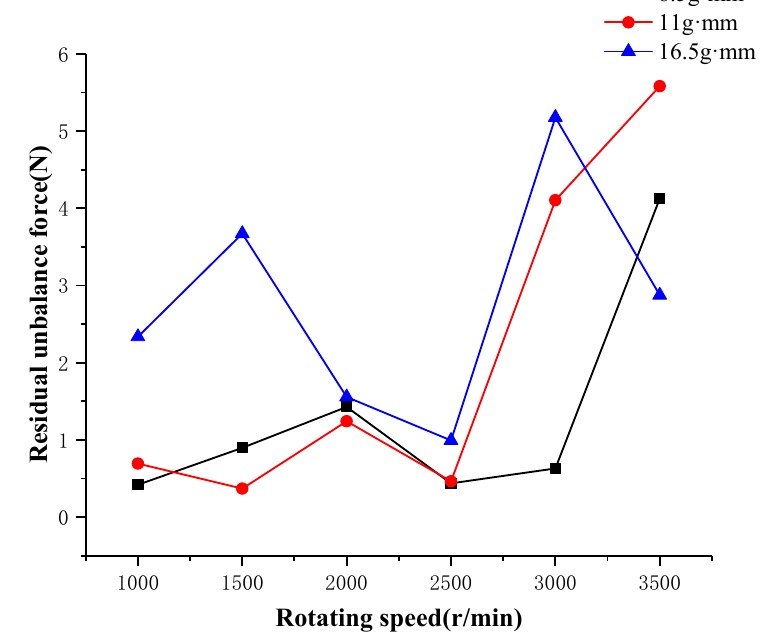
Figure 8. Residual force after balance.